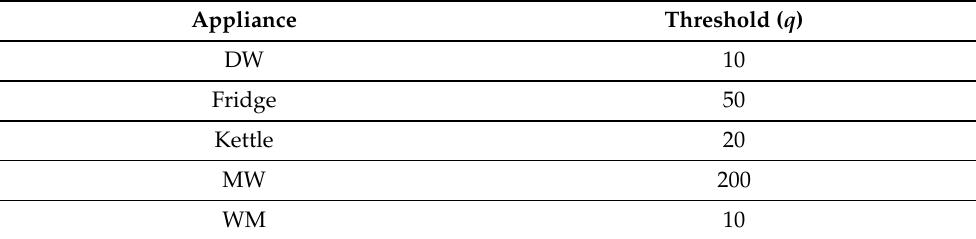
Table 2. Threshold of the